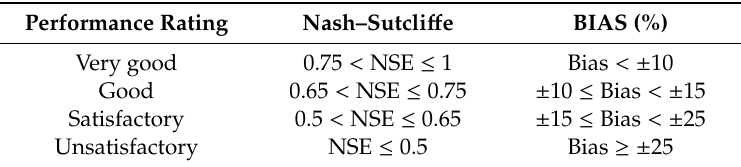
Table 4. General performance rating the stream flow for PBIAS and Nash–Sutcli ff e for a monthly time step